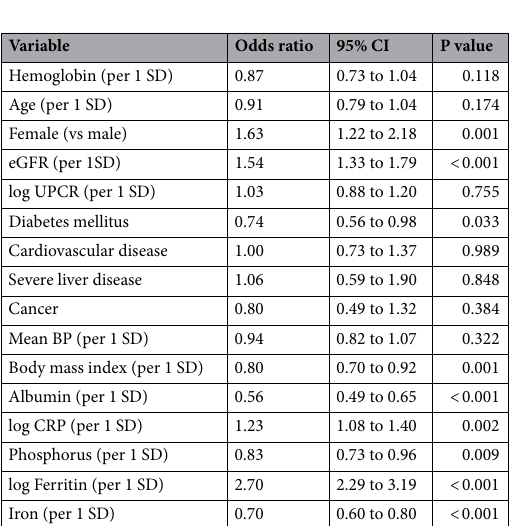
Figure 4. Inflammation divided by TSAT and serum iron.